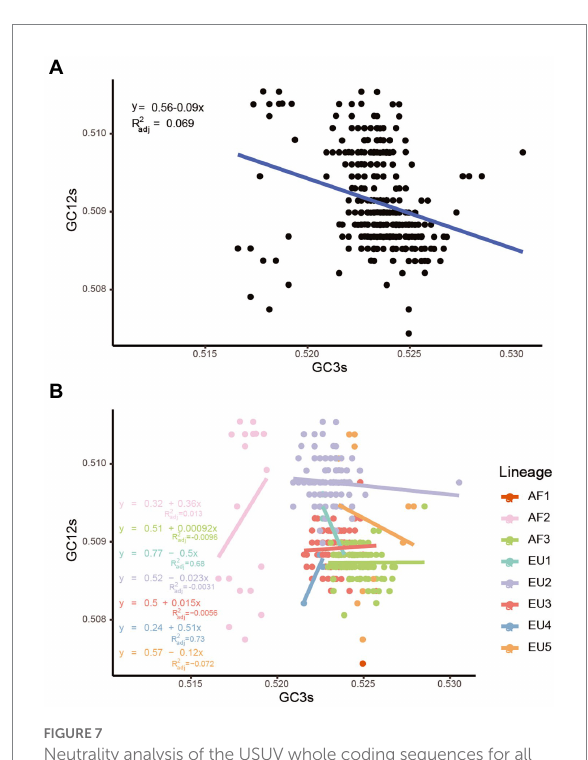
FIGURE 7 Neutrality analysis of the USUV whole coding sequences for all strains (A) and different lineages (B)